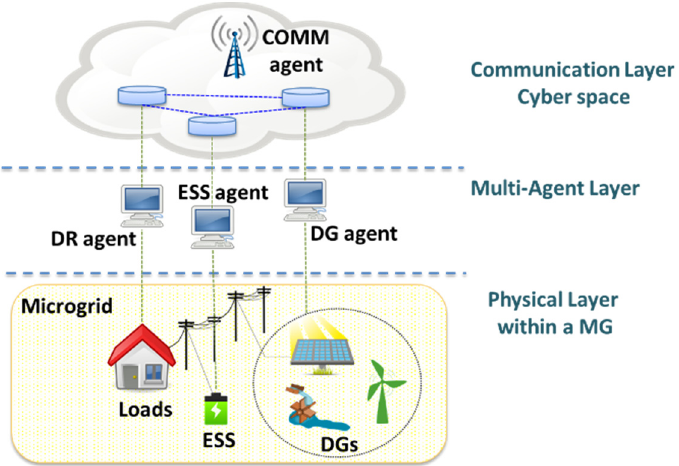
Figure 2. General framework of the proposed agent-based active power management scheme .